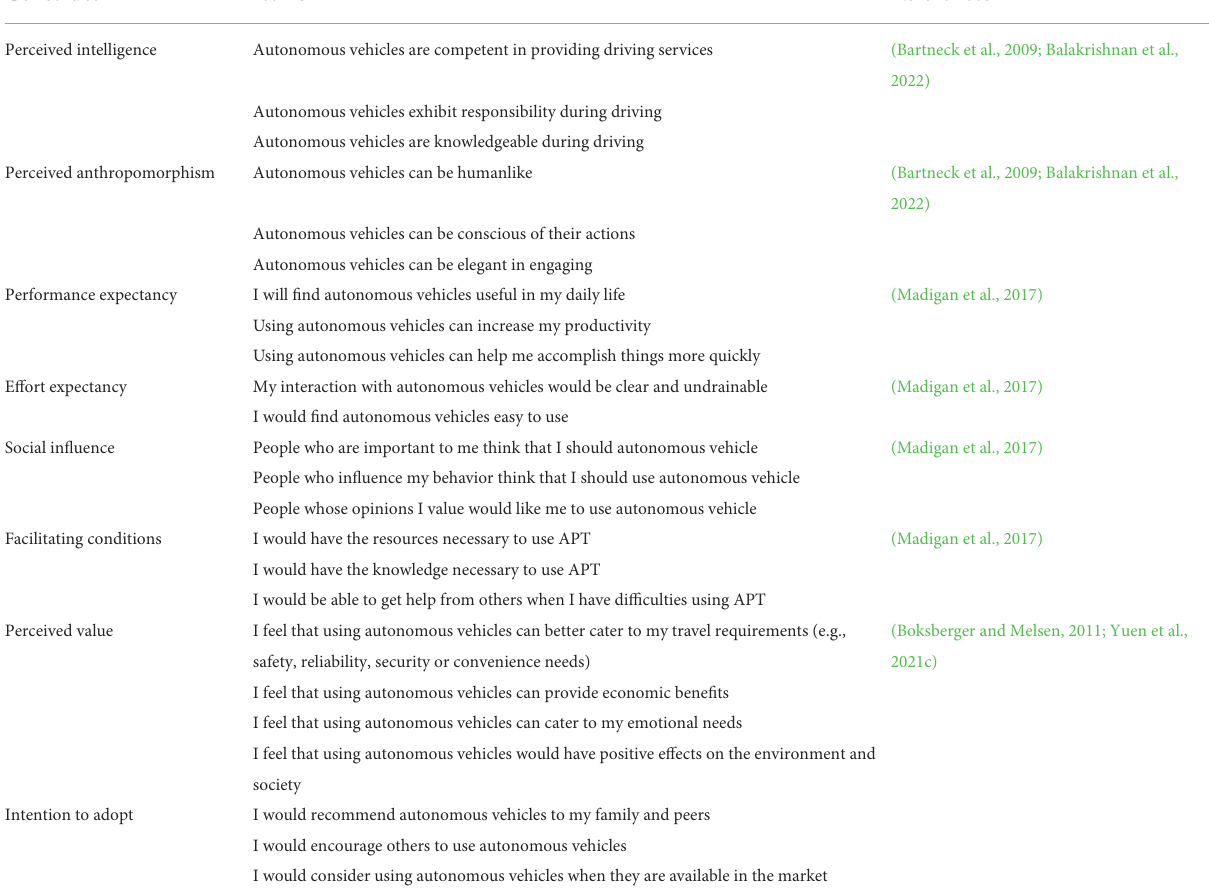
TABLE 1 Questionnaire